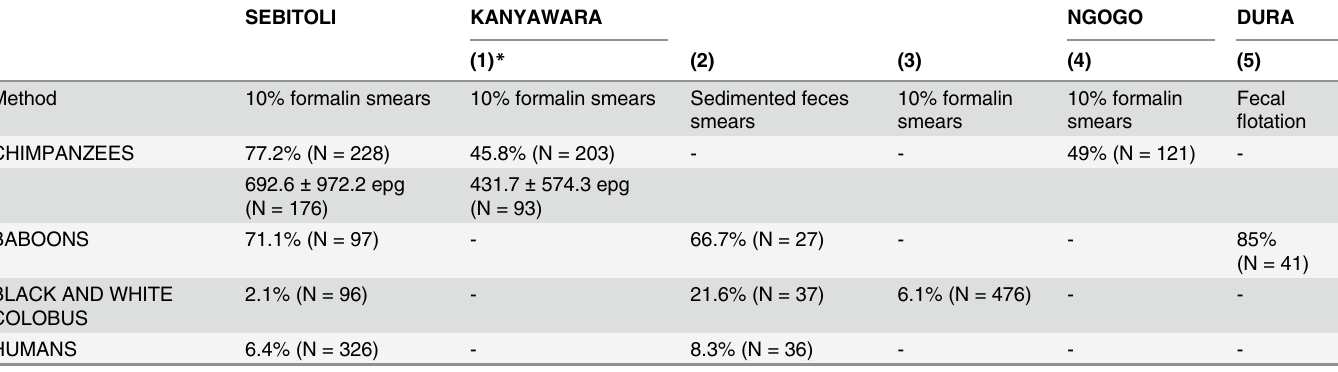
Table 2. Comparisons of the prevalence of hookworm-like eggs and of the corrected parasite loads between different sites within Kibale National Park, Uganda. (1) [55]; (2) [18], (3) [54], (4) [56], (5) [57]. SEBITOLI